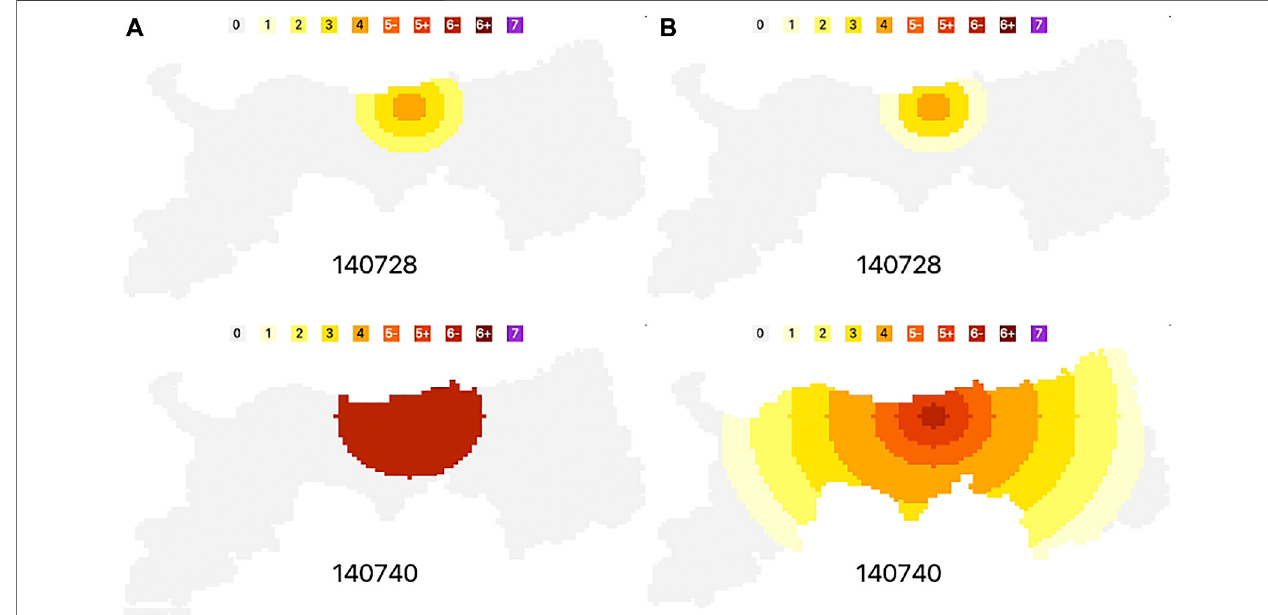
FIGURE 4 | Demonstration of seismic intensity propagation from a single observation site without site ampli fi cation: (A) PLUM method; (B) proposed method.